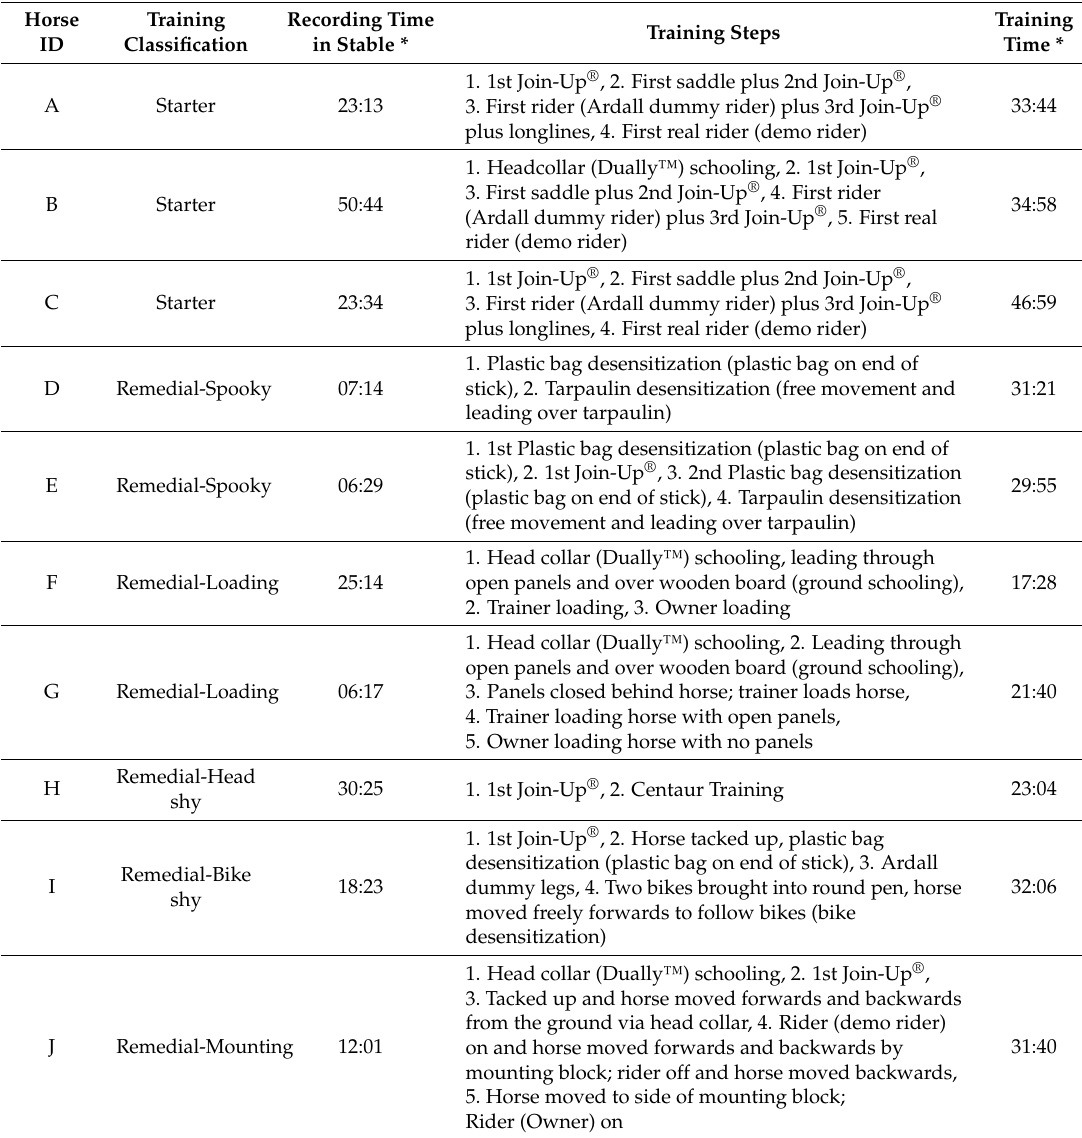
Table 2. Details of each training